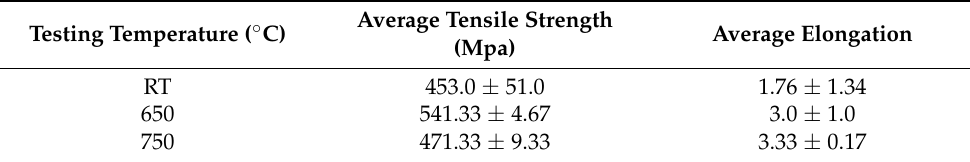
Table 2. Tensile properties of the joints with respect to